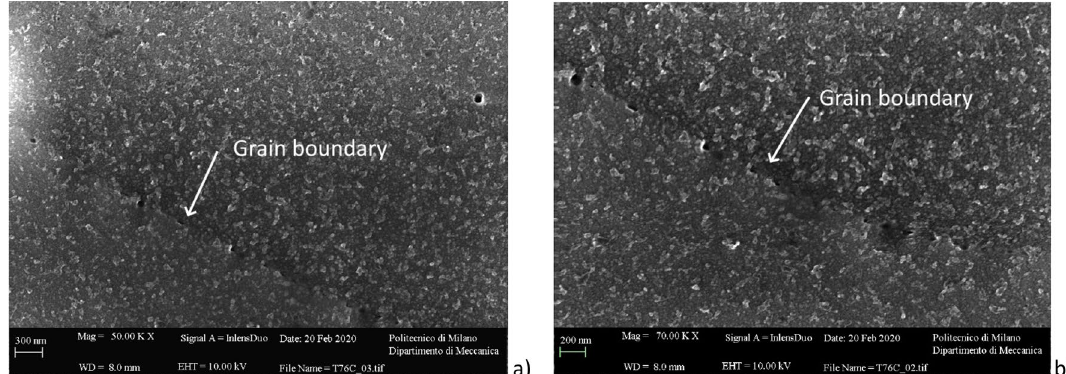
Fig. 14 Precipitate distribution at the grain boundaries—T76C temper. b is the magnification of a